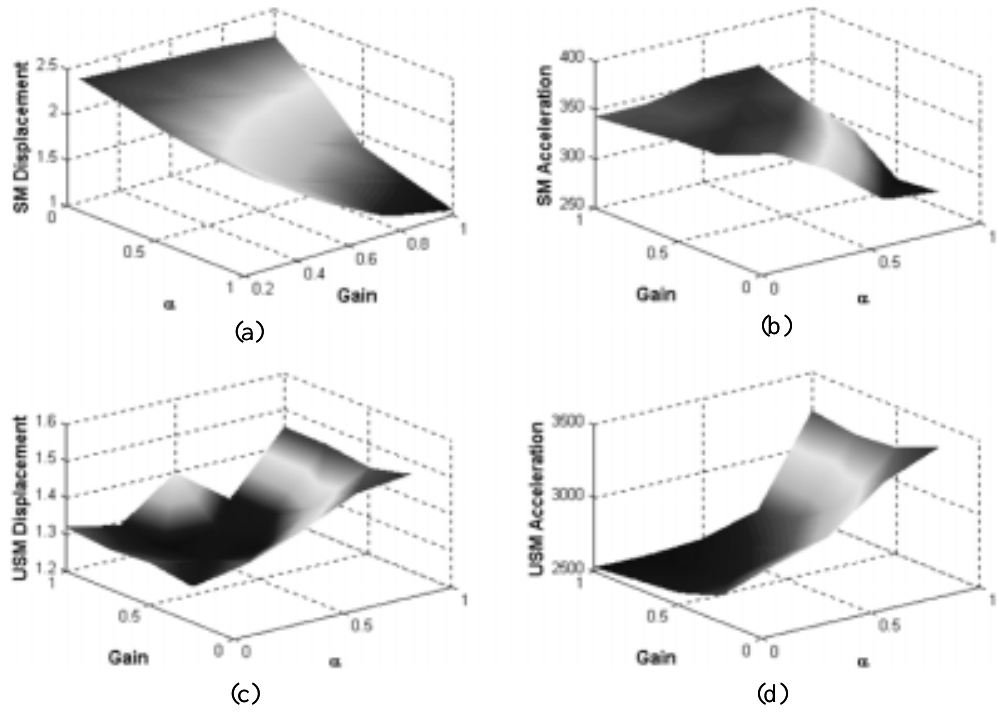
Fig. 12. Effects of α and Gain on Transient Response: (a) Sprung Mass Peak-to-Peak Displacement; (b) Sprung Mass Peak-to-Peak Acceleration; (c) Unsprung Mass Peak-to-Peak Displacement; (d) Unsprung Mass Peak-to-Peak